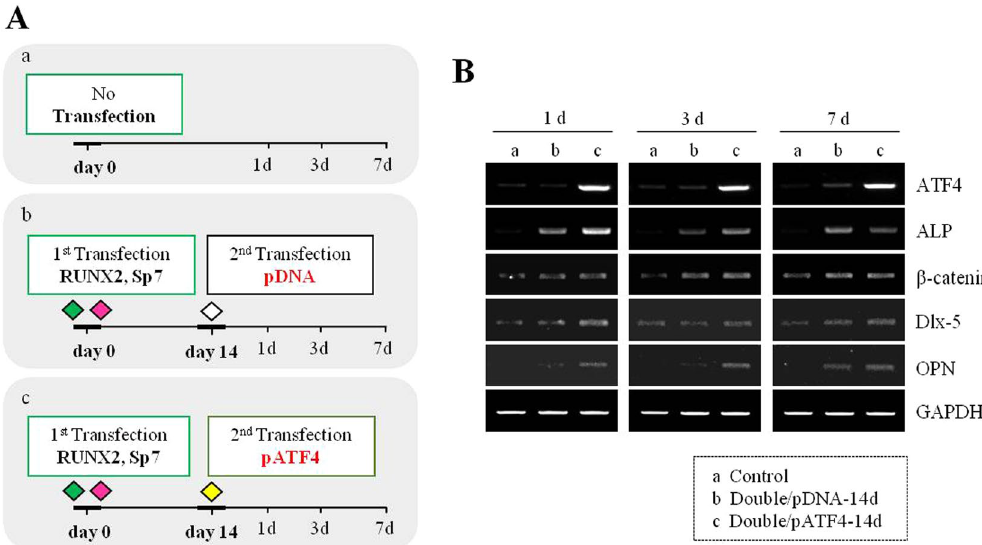
Figure 5. Gene expression following transfection of hMSCs with DNPsP coated with pDNA or pATF4. ( A ) Schematic illustration of the schedule used to determine the genes expressed upon ATF4 delivery. (a) Negative control, (b) transfection of pDNA at 14 days after RUNX2/SP7, and (c) transfection of pATF4 at 14 days after RUNX2/SP7. ( B ) RT-PCR analysis of the mRNA expression levels of ATF4, ALP, CTNNB1, Dlx5, and OPN at 1, 3, and 7 days after transfection of hMSCs with DNPsP coated with pDNA or